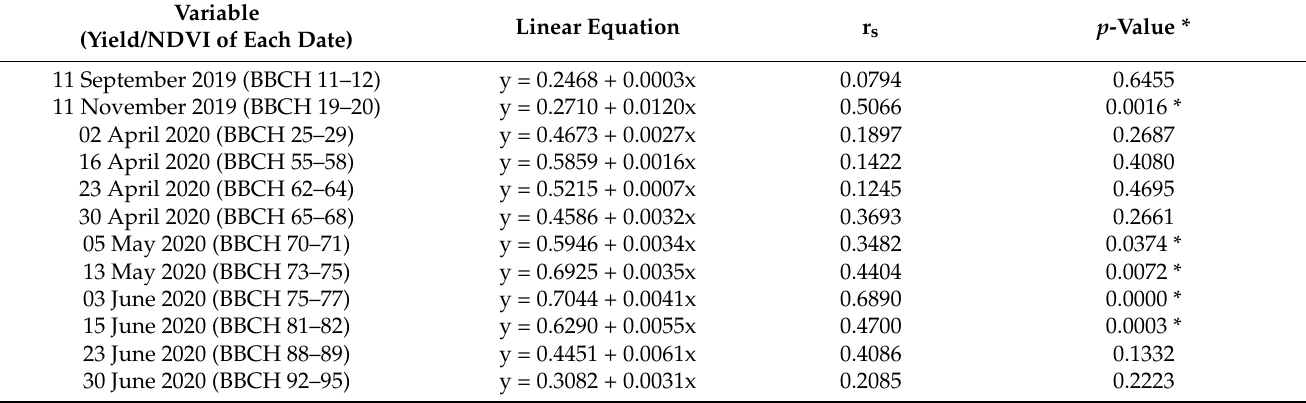
Table 4. Spearman’s rank correlation coefficients between final yield and normalized difference vegetation index (NDVI) values of each flight date during winter oilseed rape growing season